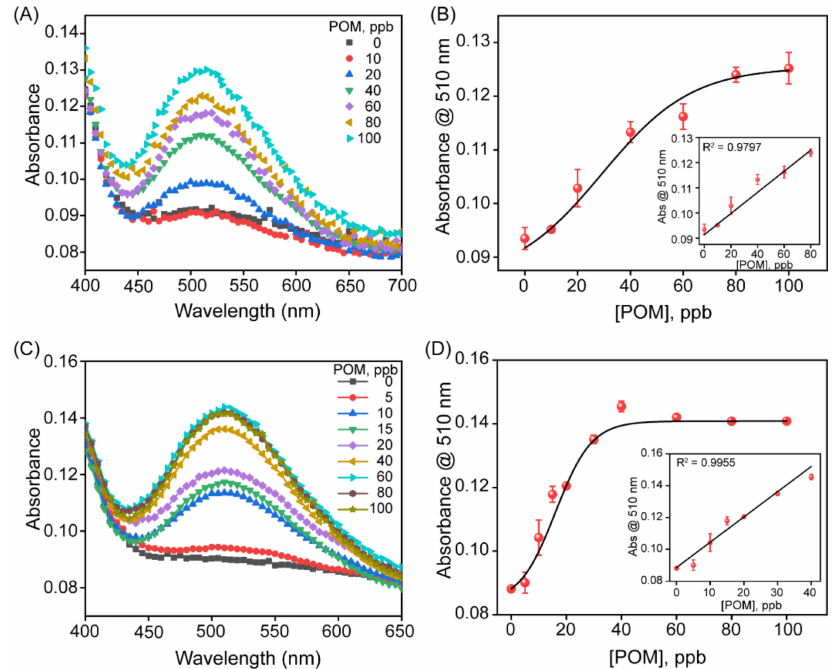
Figure 6. Detection of paraoxon methyl in complex matrices. ( A ) UV-Vis absorbance spectra of varying POM concentrations (from 0 to 100 ppb) spiked in tap water. ( B ) Plot of absorbance values at 510 nm as a function of POM concentration spiked in tap water, the black line indicates the dose– response curve fitting to guide the eye while linear fitting in the inset gives the LOD of 14.5 ppb. ( C ) UV-Vis absorbance spectra of varying POM concentrations (from 0 to 100 ppb) spiked in